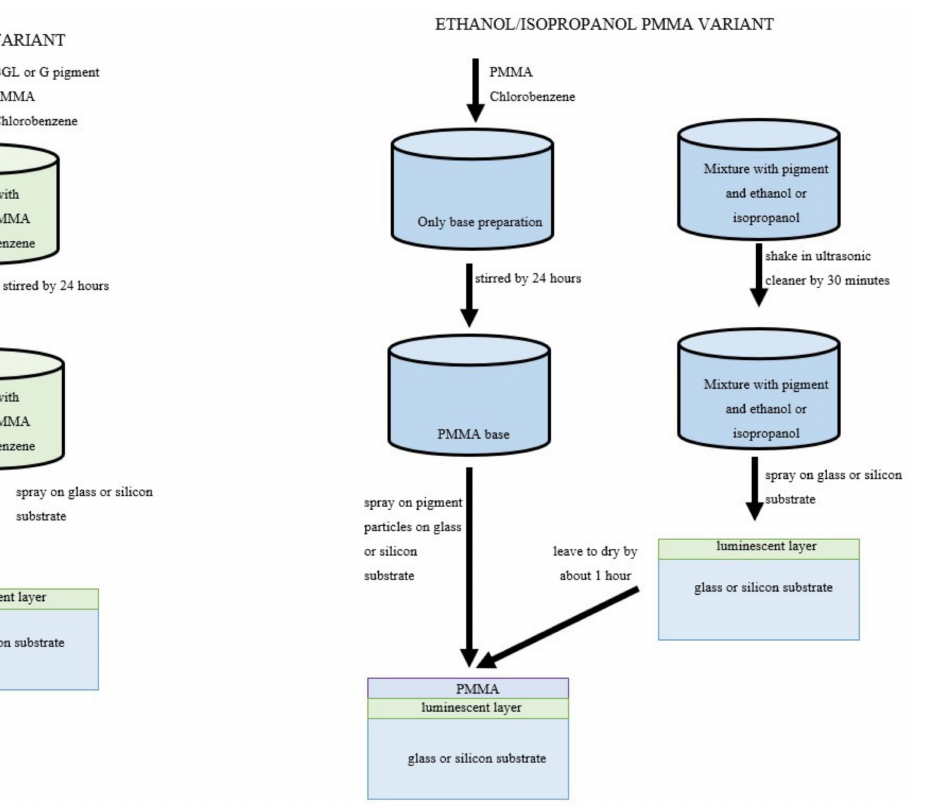
Figure 2. Schematic of the experimental process.